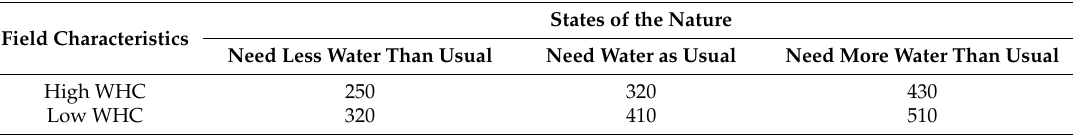
Table A2. Expected water requirement for each state of the nature calculated by running AQUACROP for processing tomatoes in northern Italy from 1993 to